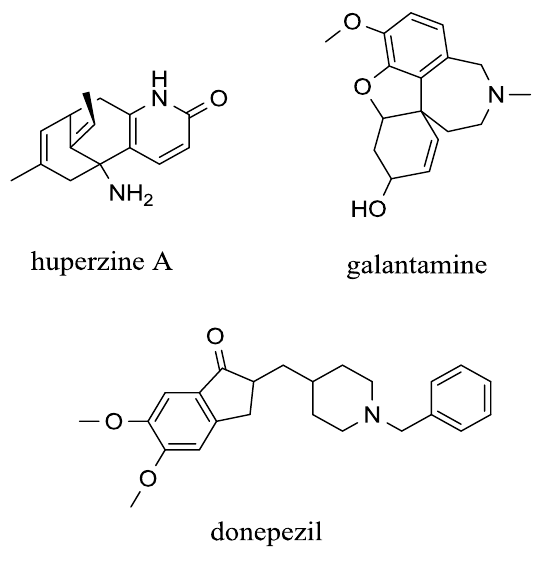
Figure 2. Structure of cited compounds that cross the blood brain